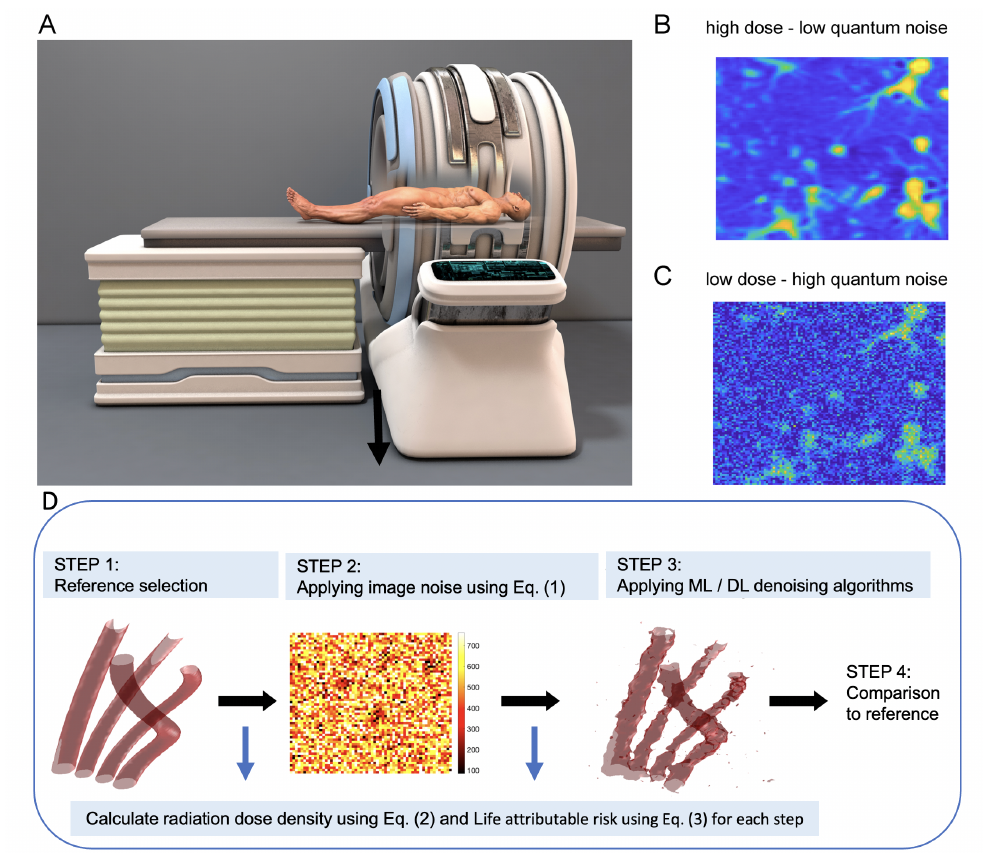
Figure 1. Graphical representation of our proposed pipeline workflow for automated generation and risk assessment of CT images. ( A ): Initial reference data can be either a set of real CT-data generated using high-dose radiation or artificially simulated data. ( B ) Exemplary high-quality and low-quantum noise image of lung vessels. ( C ) exemplary low-dose CT images with high quantum noise. ( D ) Workflow from image generation to subsequent benchmarking of ML/DL-denoising methods. Starting with high-quality data or artificially generated reference data, respectively, a spectrum of image noise σ is added for a multitude of combinations from patient-specific and CT control variables, as suggested in Equation (1). The noisy images are then denoised using various state-of-the-art methods and the processed images are compared to the original reference